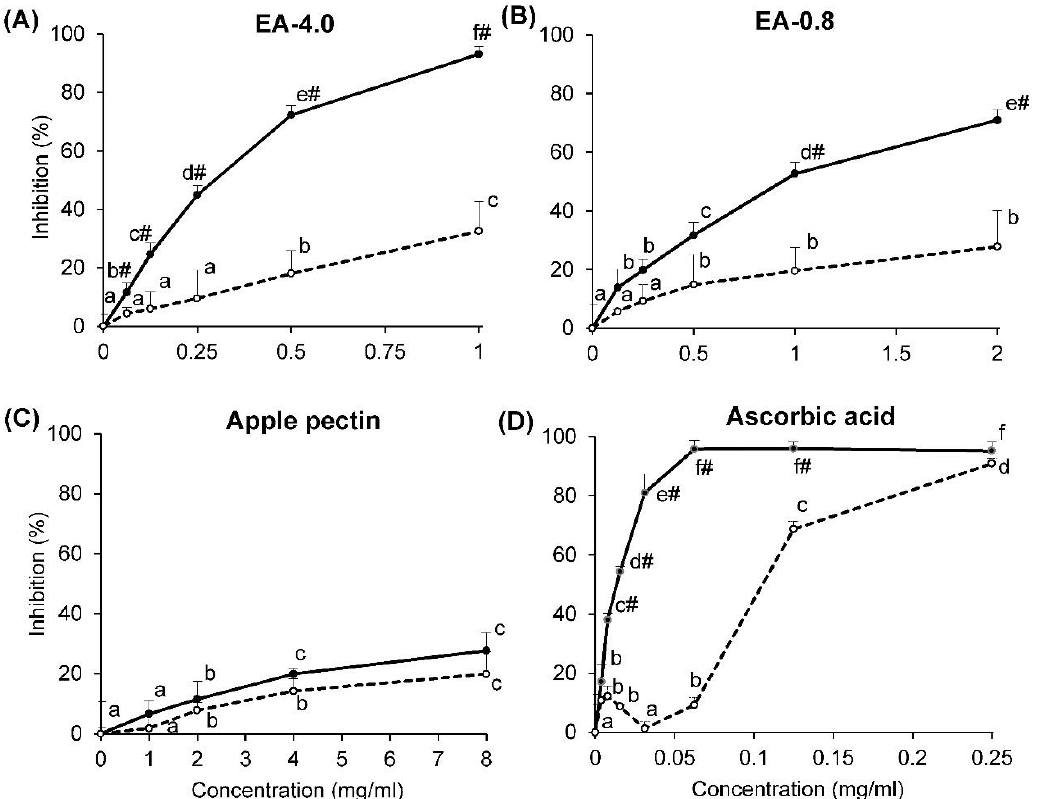
Figure 4. The inhibition reduction in ferricytochrome c (solid line) and activity of xanthine oxidase (dotted line) by pectins EA-4.0 ( A ) and EA-0.8 ( B ) in comparison with commercial apple pectin ( C ) and ascorbic acid ( D ). Data are presented as the mean ± SD of three independent experiments. Different lowercase letters (a, b, c, d, e, f) for the same reaction at different concentrations indicate significant differences ( p < 0.05, LSD test). # — the differences are significant compared with the xanthine oxidase inhibition ( t -test).